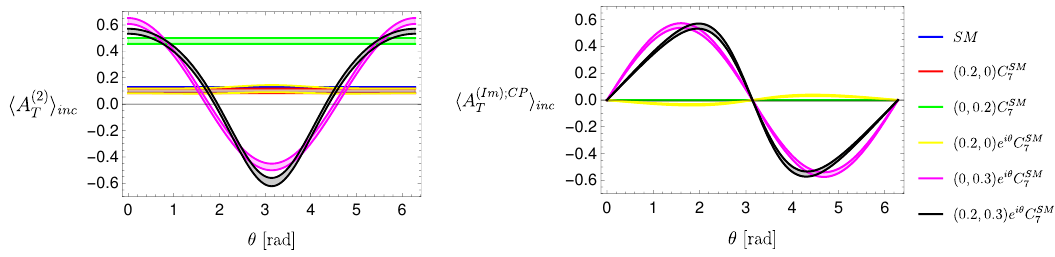
Figure 5 . Variation with the NP weak phase θ of h A (2) [0 . 0008 , 0 . 257] GeV 2 . The selected NP scenarions are shown, taking into account meson-mixing effects. Note, in particular, that the second and third scenarios have no impact on h A ( Im ); CP